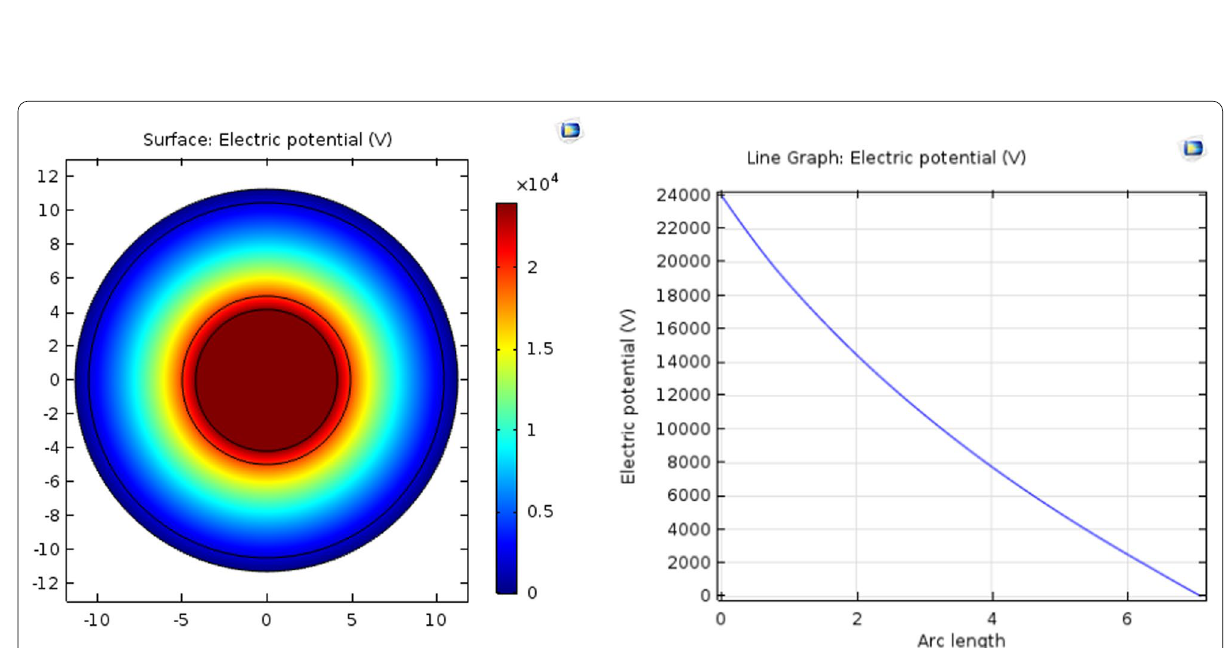
Fig. 11 Electric potential distribution in medium‑voltage (MV) cables with zinc oxide (ZnO) filling of cross‑linked polyethylene/5‑ZnO irradiated at 25